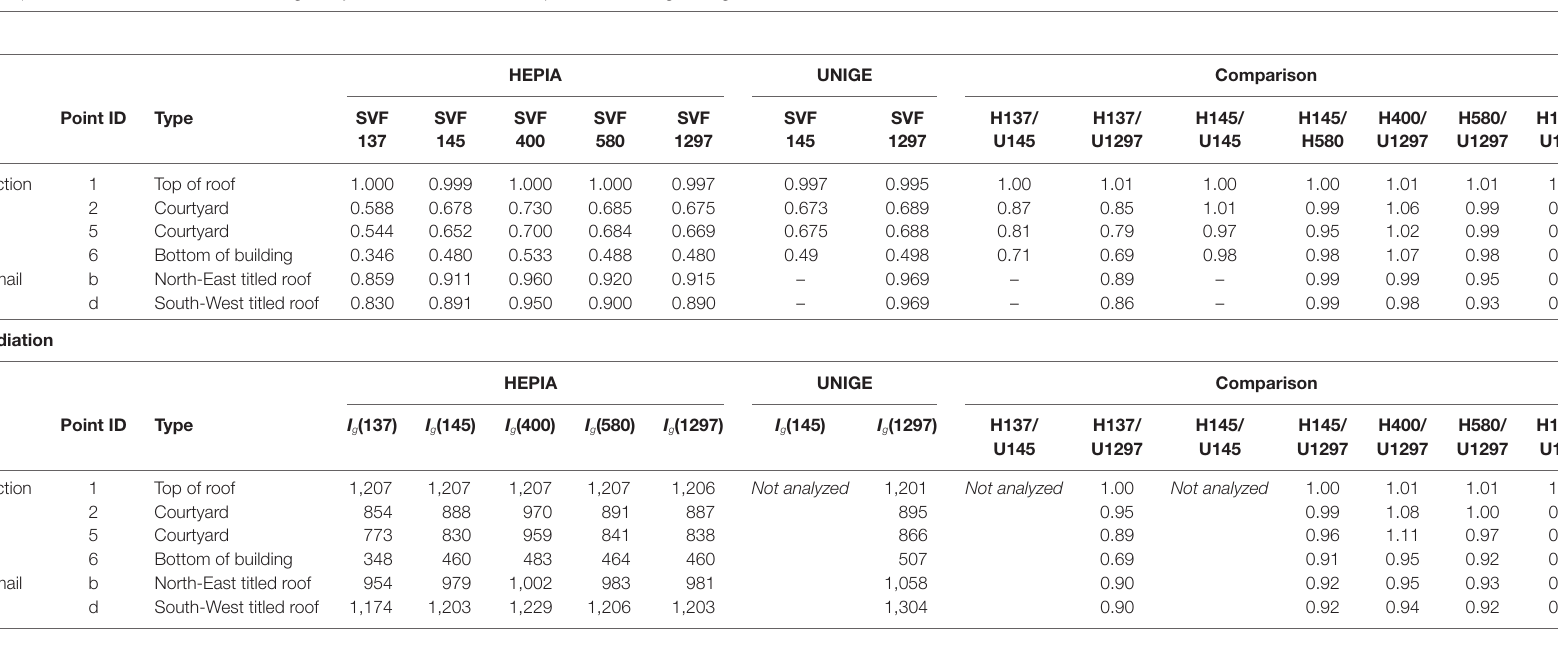
tABLe 1 | Comparison on sky view factor (SVF) values (at the top) and irradiation values I g on horizontal (Jonction) and inclined (Unimail) surfaces (in kWh/m 2 /year) (at the bottom) for both studied areas (Jonction and Unimail) between “U”—UNIGE’s model using fisheye catchment and “H”—hepia’s model using the digital surface model from LIDAR. sVF hePIA UNIGe Comparison